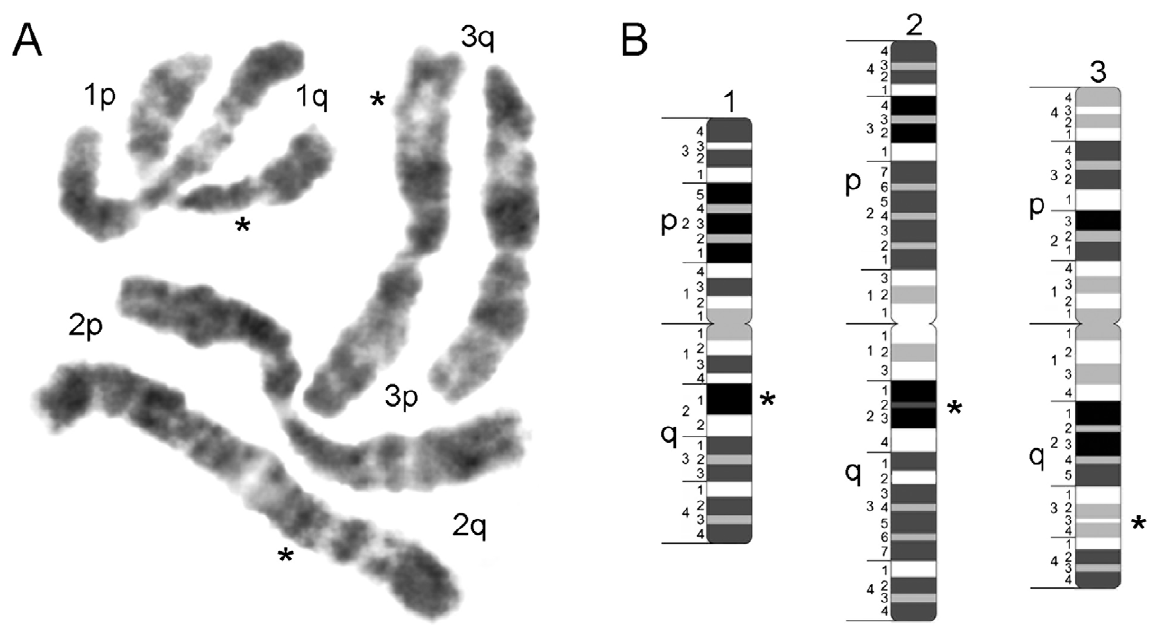
Figure 1. The construction of idiograms for mitotic chromosome of Aedesaegypti . Early metaphase chromosomes of Ae. aegypti stained with YOYO-1 iodide (A) were utilized for idiogram (B) development. Chromosome numbers are shown on the top of each chromosome. Chromosomal arms p and q and numbered divisions and subdivisions are shown on the left side of the idiograms. Landmarks are indicated by asterisks.